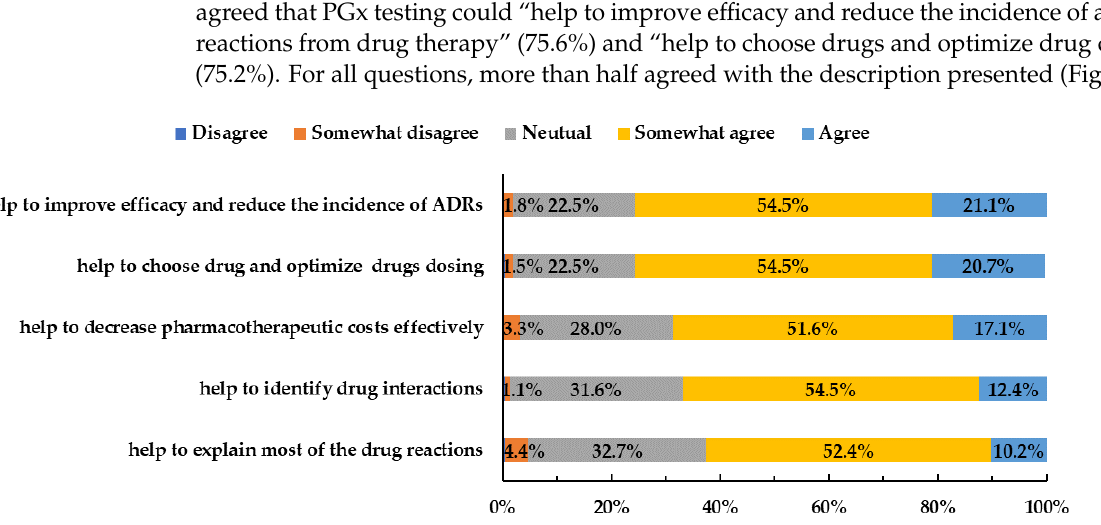
Table 3. Value of PGx testing in different treatment areas (scale 0 – 100). Areas